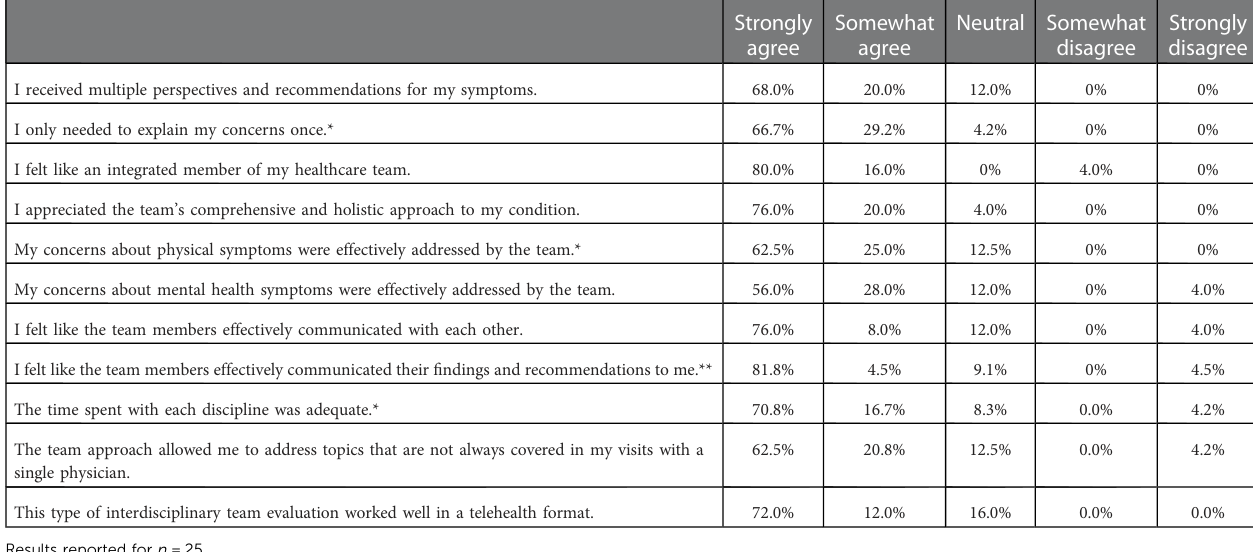
TABLE 5 Experiences with the multidisciplinary telehealth clinic